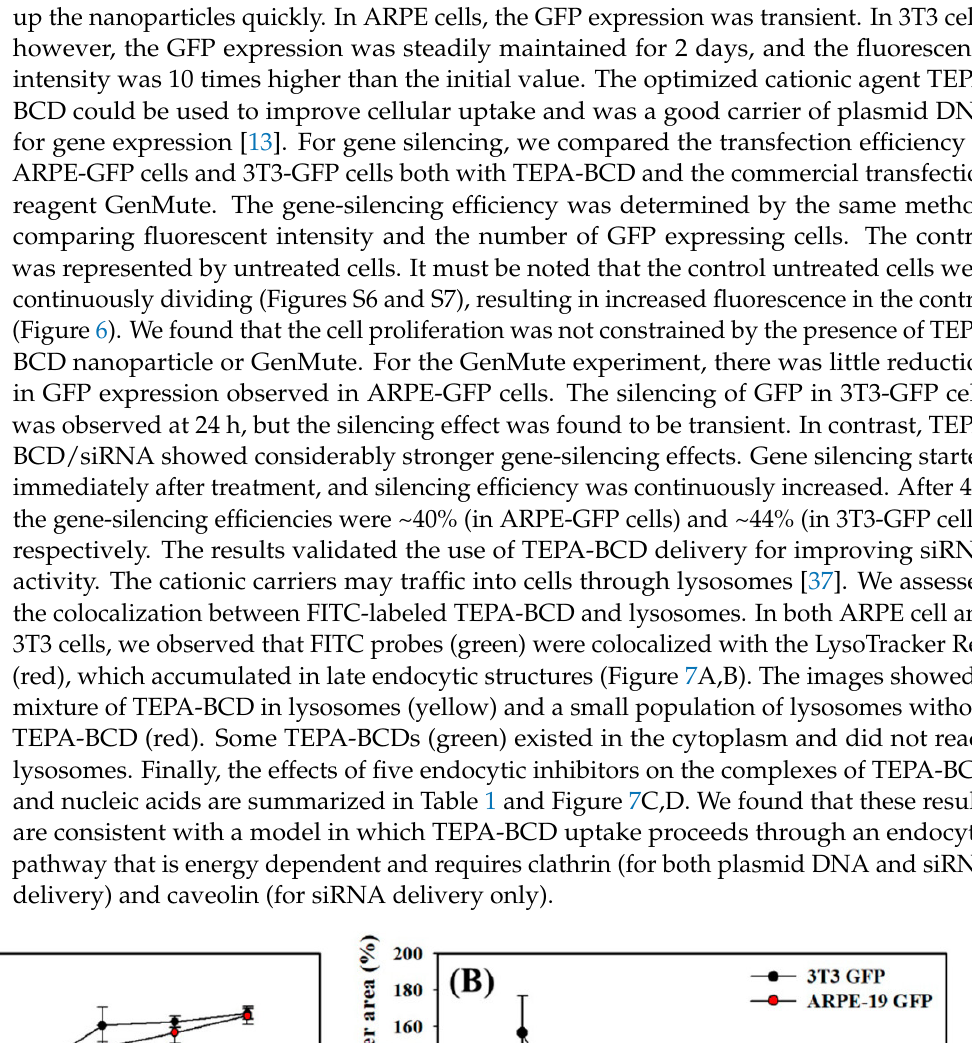
Figure 3. The size and zeta potential of TEPA-BCD/plasmid DNA ( A ) and TEPA-BCD/siRNA polyplexes ( B ) at various carrier/drug ratios using Zetasizer. In 100 μ L solution, TEPA-BCD amounts ranged from 0.21 to 1.71 μ g and the fixed amounts of plasmid DNA and siRNA were 1 μ g and 13.3 ng, respectively. Error bars represent the standard deviation (n = 3).